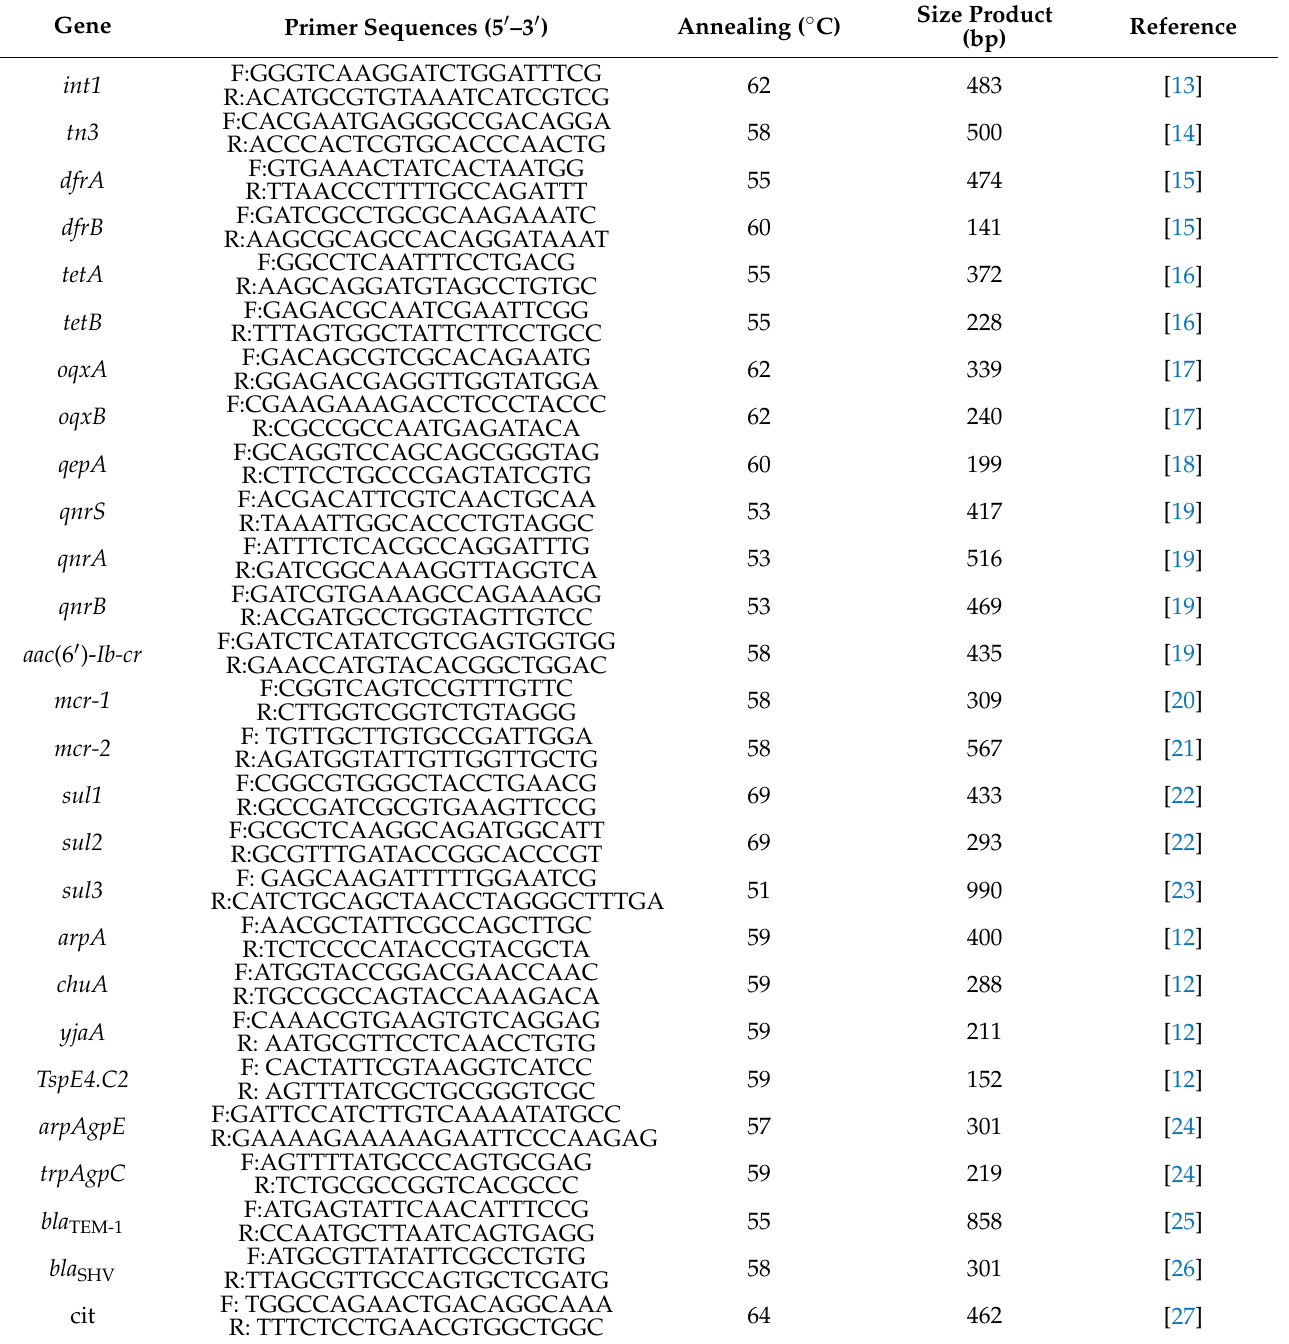
Table 1. Primers used for the PCR detection of resistance genes and phylogroups. Gene Primer Sequences (5 (cid:48) –3 (cid:48)